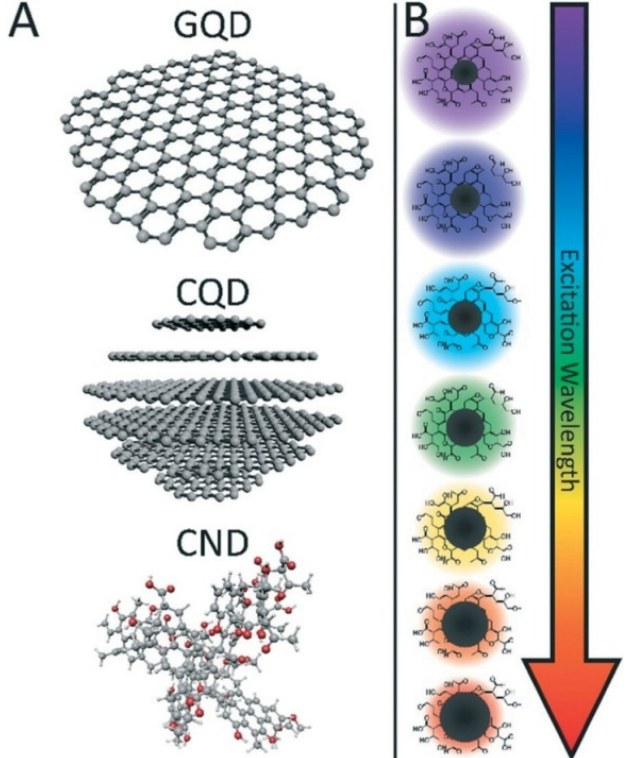
Scheme 2. ( A ) Representative structures of single-layer graphene quantum dots (GQDs), multilayered carbon quantum dots (CQDs) and amorphous carbon nanodots (CNDs). ( B ) Representation